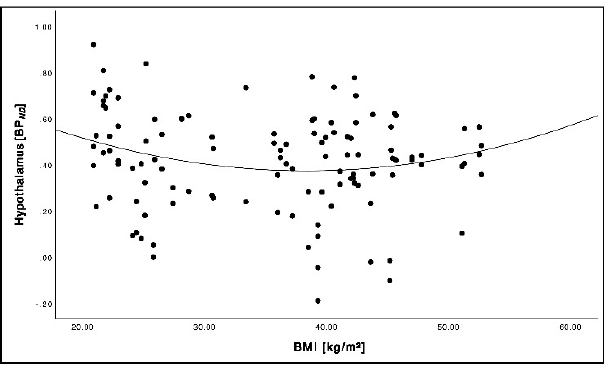
Figure 6. Relationship between BMI and NAT BP ND across the cohort (pooled baseline and follow-up data) in the hypothalamus.